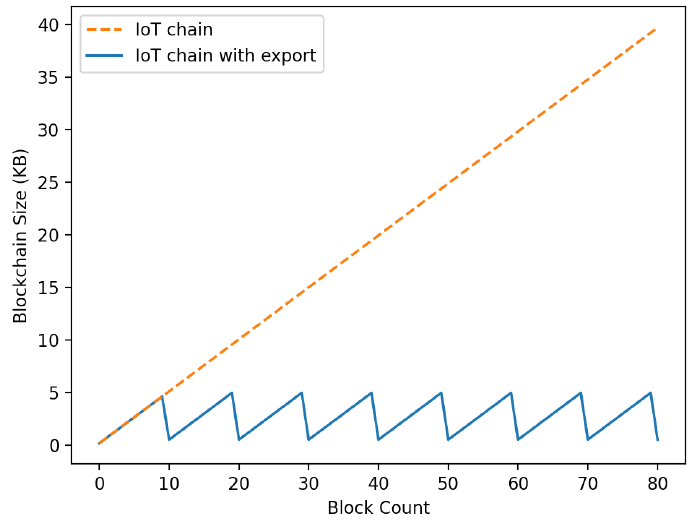
Figure 10. Size comparison according to IoT-Chain export